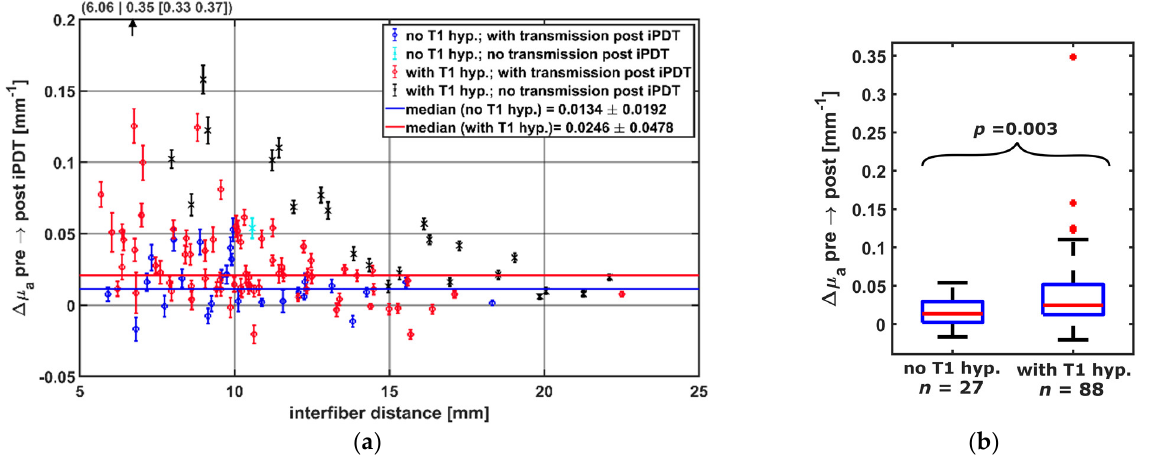
Figure 7. ( a ) Calculated Δµ a dependent on the interfiber distance between CDF-pairs. Colors indicate whether transmission was detectable post iPDT and whether intrinsic T1 hyperintensity was observed (see legend). For better visibility, the data point at (6.06|0.35) is omitted. ( b ) Comparison of Δµ a of CDF-pairs with and without local intrinsic T1 hyperintensity, considering only pairs with transmission pre iPDT and interfiber distance ≤ 19 mm .